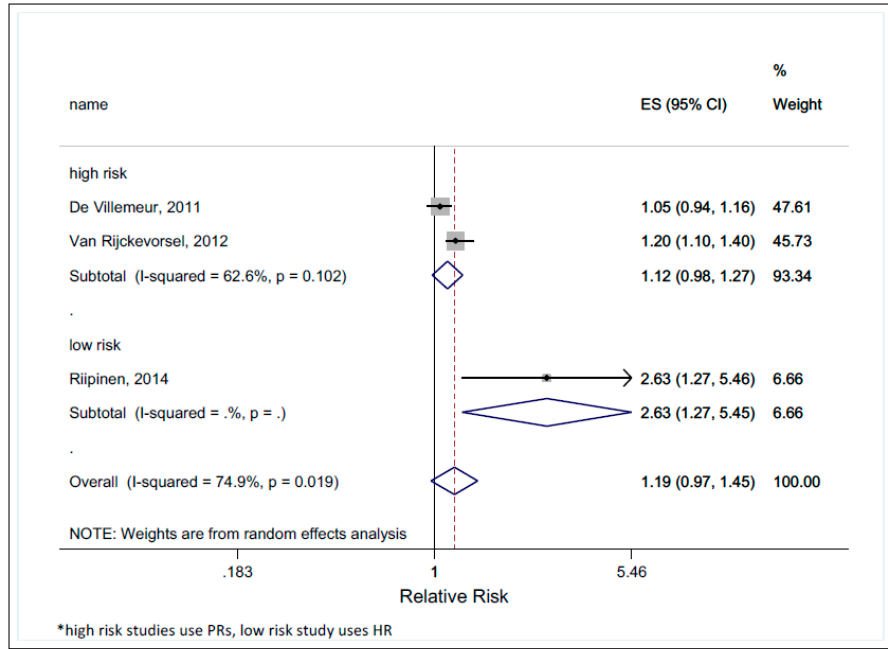
Figure 4. The effect size (ES) of relative risk by study’s risk of bias. Figure 4. The e ff ect size (ES) of relative risk by study’s risk of